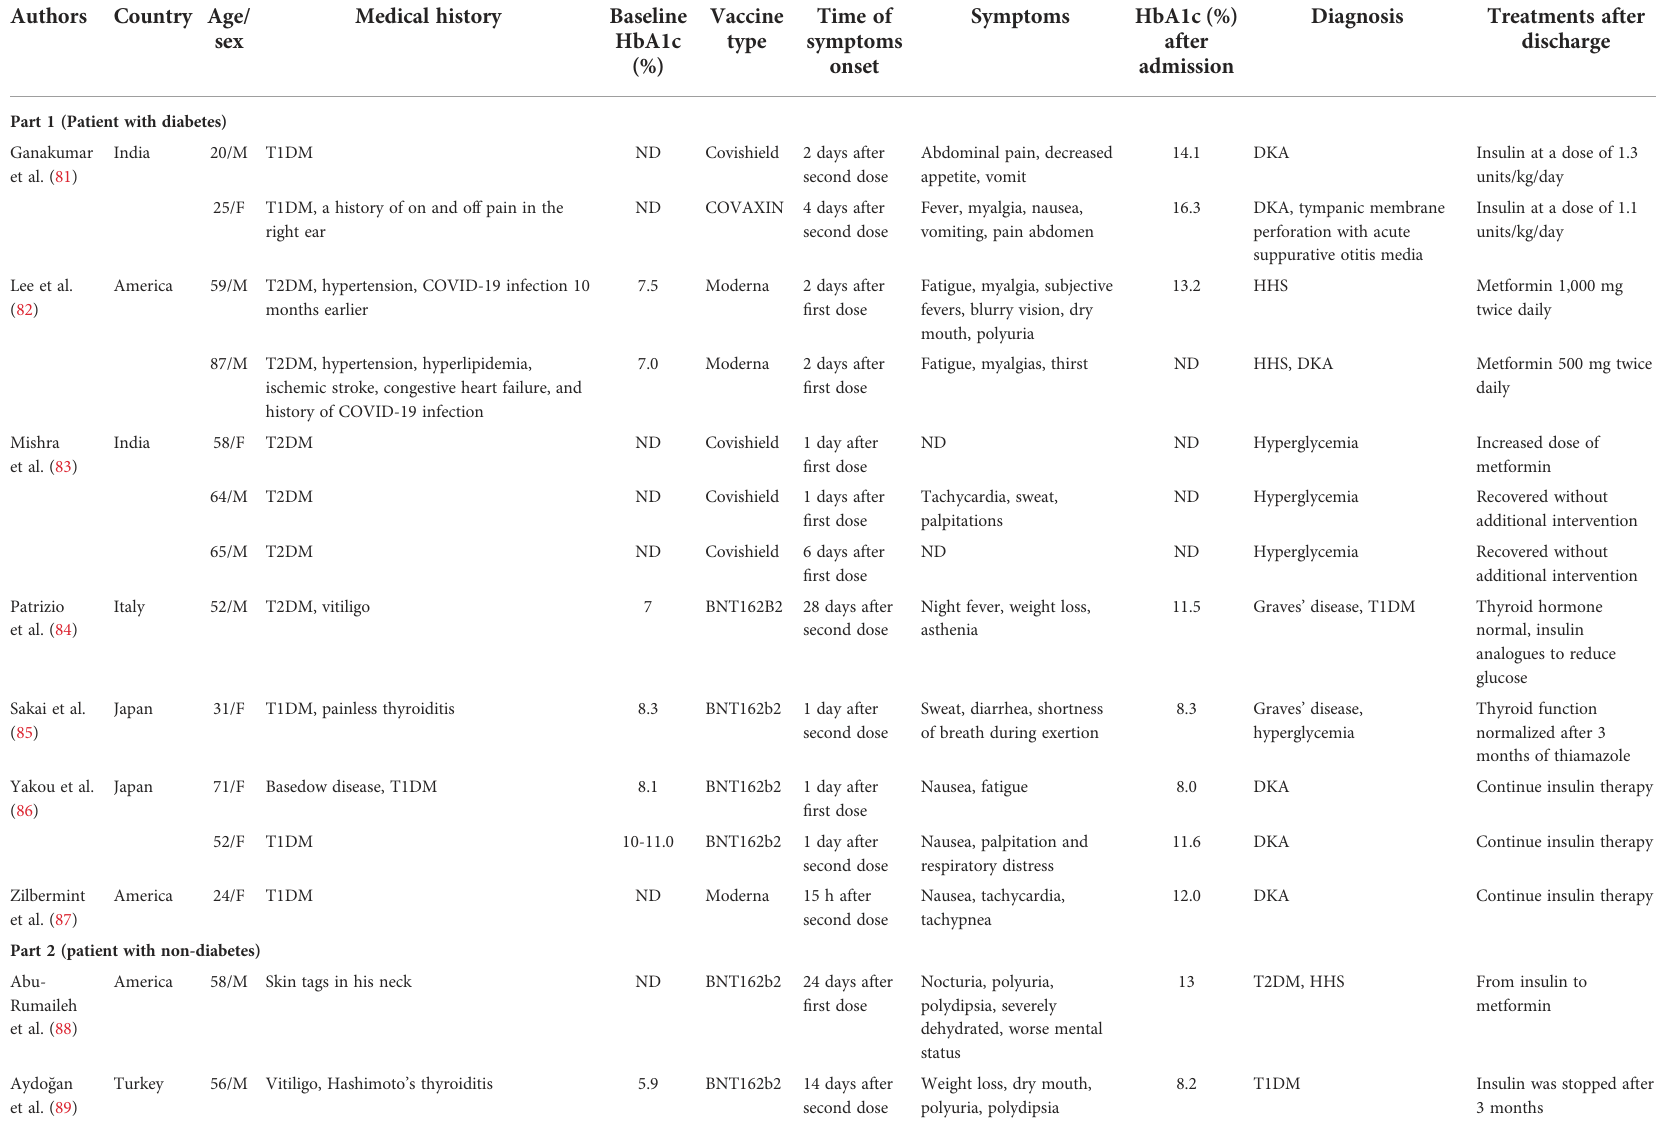
TABLE 2 Summary cases of hyperglycemia following COVID-19 vaccination in patients with or without